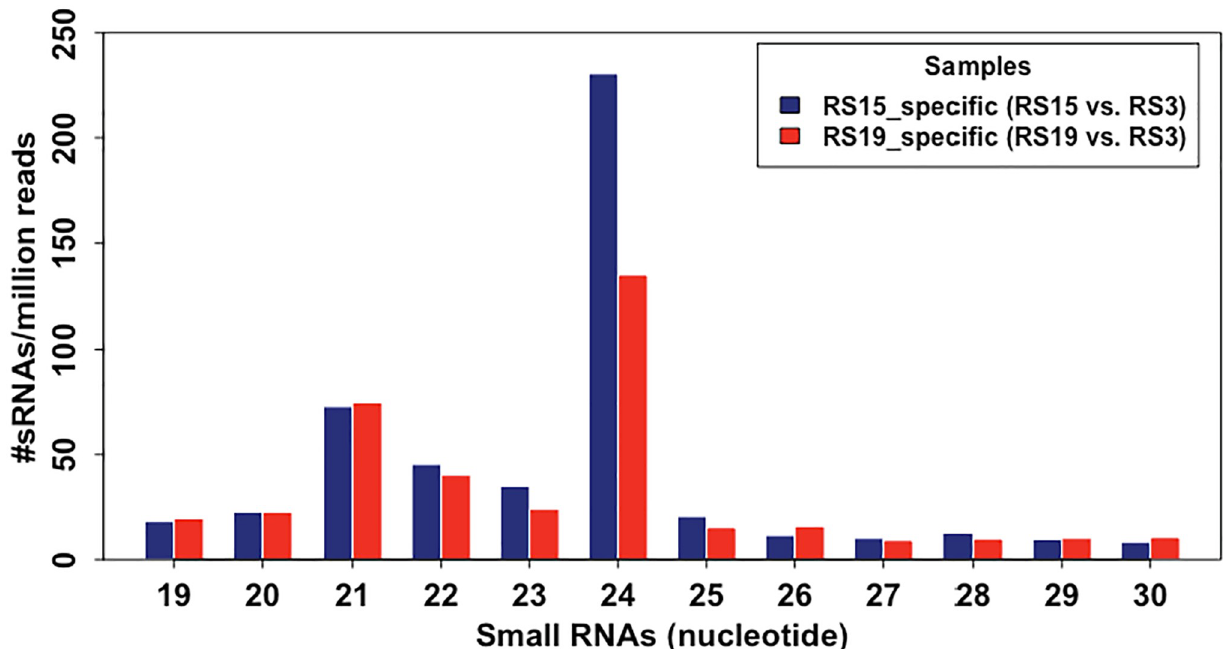
Fig 4. Profiles of putative sRNAs transferred from sweet cherry scions to rootstocks. RS15_specific and RS19_specific are sRNAs found in the grafted rootstocks, RS15 and RS19, but absent in the ungrafted.